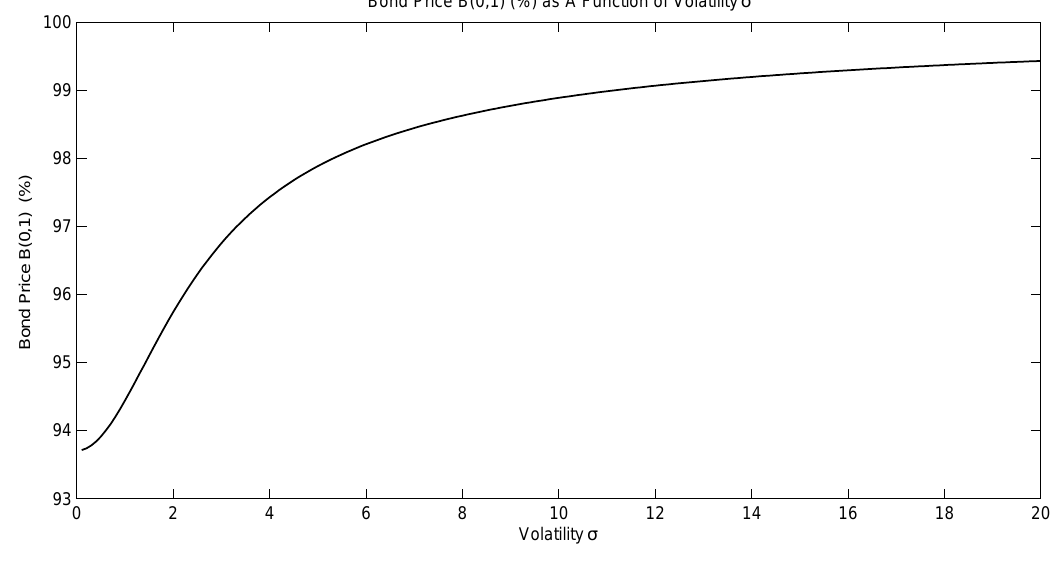
Figure 2. Bond price B ( 0,1 ) (%) as a function of volatility σ